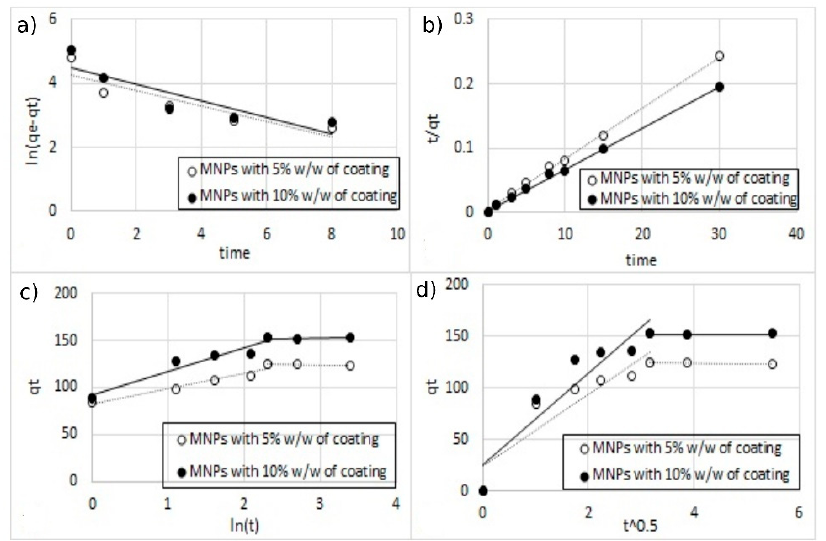
Figure 15. The fitting of different kinetic models for single-ion adsorption (Cu 2+ ) onto MA function- alized with 5% and 10% w / w of coating, ( a ) pseudo-first-order, ( b ) pseudo-second-order, ( c ) Elovich model, and ( d ) intra-particle diffusion model.